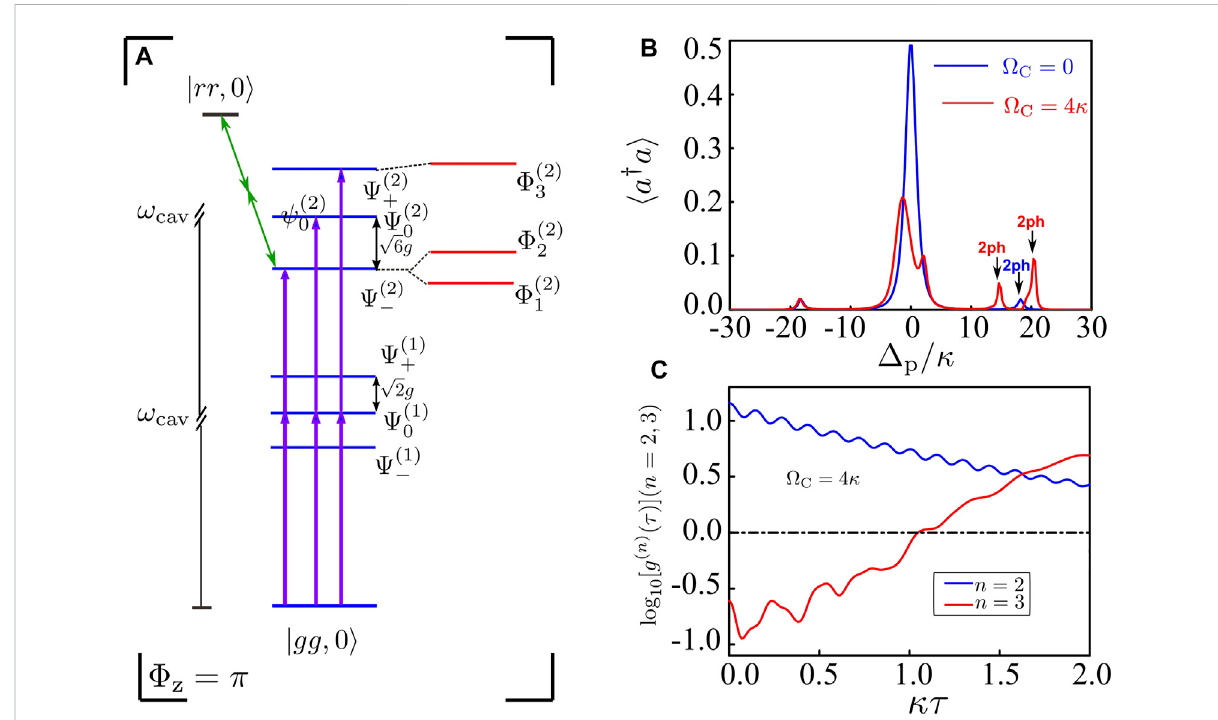
FIGURE 4 (Color online) (A) Schematicenergy-level structure illustrating theenergysplitting inducedby Ω C in thecase of Φ z = π . (B) Numerical results for 〈 a † a 〉 asfunctionsofnormalizeddetuning Δ curve) and log 10 [ g (3) ( τ )] (wathet blue solid curve) with Δ p = 21.3 κ . In (b) Ω P = 1.5 κ and in (c) Ω P = 2.0 κ , other system parameters are the same as in Figure 2.